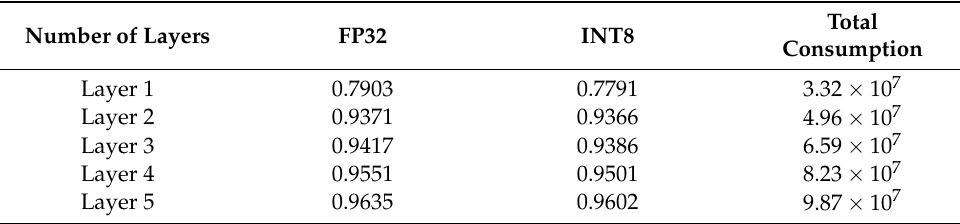
Table 1. Accuracy comparison between FP32 and INT8 in different